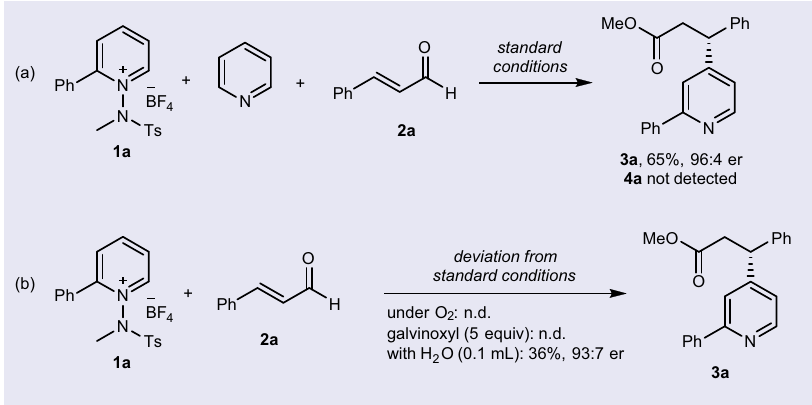
Fig. 4 Control experiments. a Reaction with mixture of 1a and pyridine. b Reactions with the presence of O 2 , galvinoxyl free radical, and H 2 O.